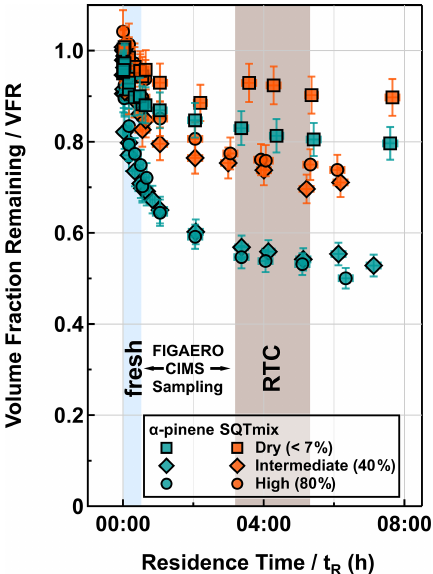
Figure 1. Evapograms for α -pinene (turquoise) and SQTmix (or- ange) SOA particles under dry ( < 7%), intermediate-RH (40% RH), and high-RH (80% RH) conditions. The blue (fresh) and brown (RTC) areas indicate the corresponding sampling periods of